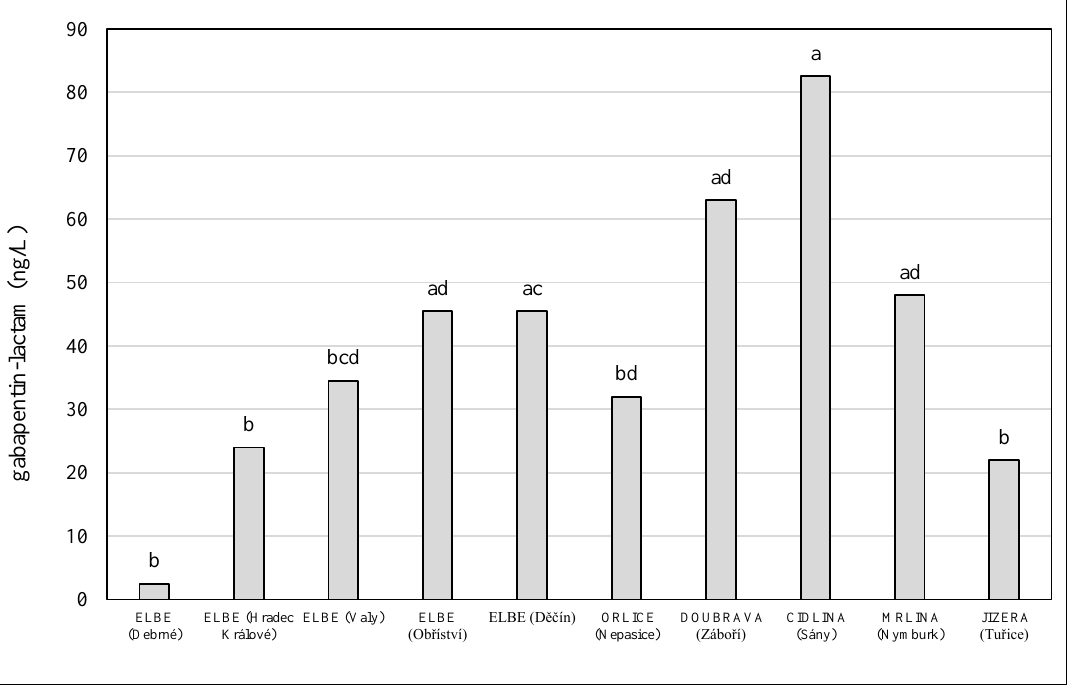
Figure 10. Median values of carbamazepine concentration at the sampled locations during the year 2021. Significant differences among the localities are indicated by different alphabetical superscripts ( p < 0.05).